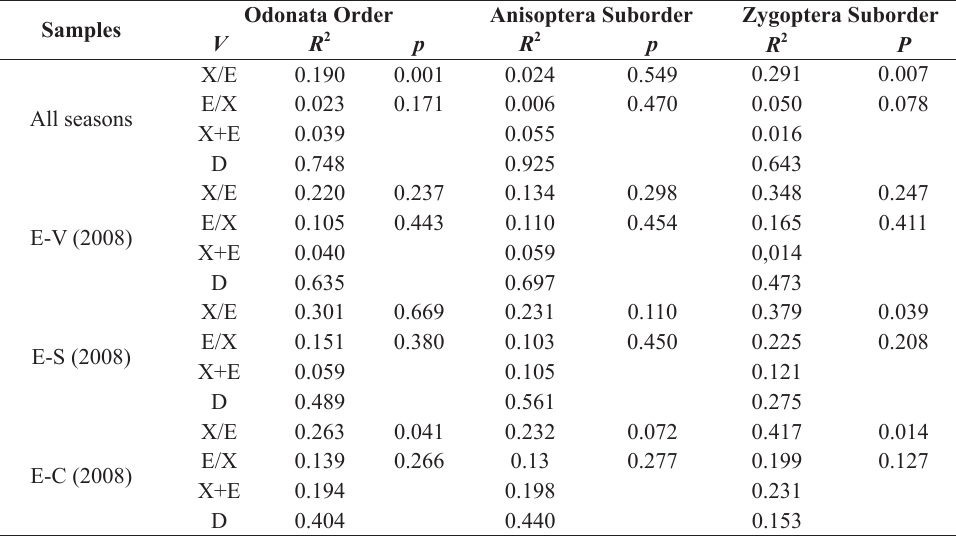
Results of the community structure and distribution variation partitioning (RDA). The letter V represents the variables. The ratio X/E corresponds solely to the environmental effect, E/X dolely to the spatial effect, X+E the interaction effects, and [D] the